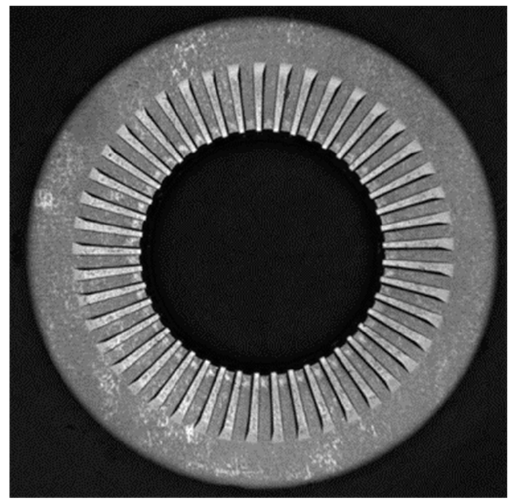
Figure 7. Knurled washer: case study component.